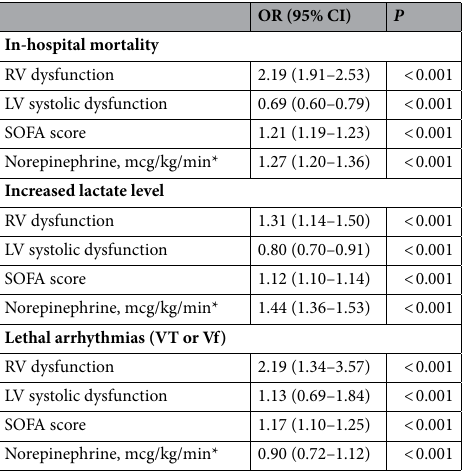
Table 3. Multivariate logistic regression analyses. CI confidence interval, LV left ventricular, OR odds ratio, RV right ventricular, SOFA Sequential Organ Failure Assessment, Vf ventricular fibrillation, VT ventricular tachycardia. *For every 0.1 mcg/kg/min increase. The doses of other catecholamines were converted into norepinephrine equivalent values and were